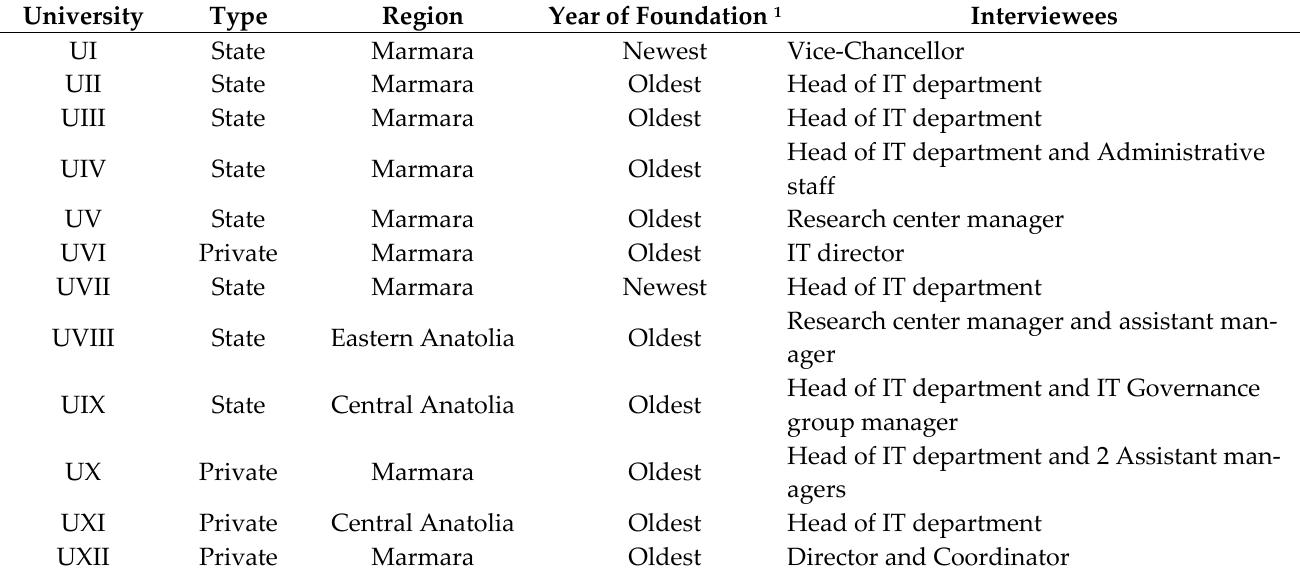
Table 1. Universities where case studies were